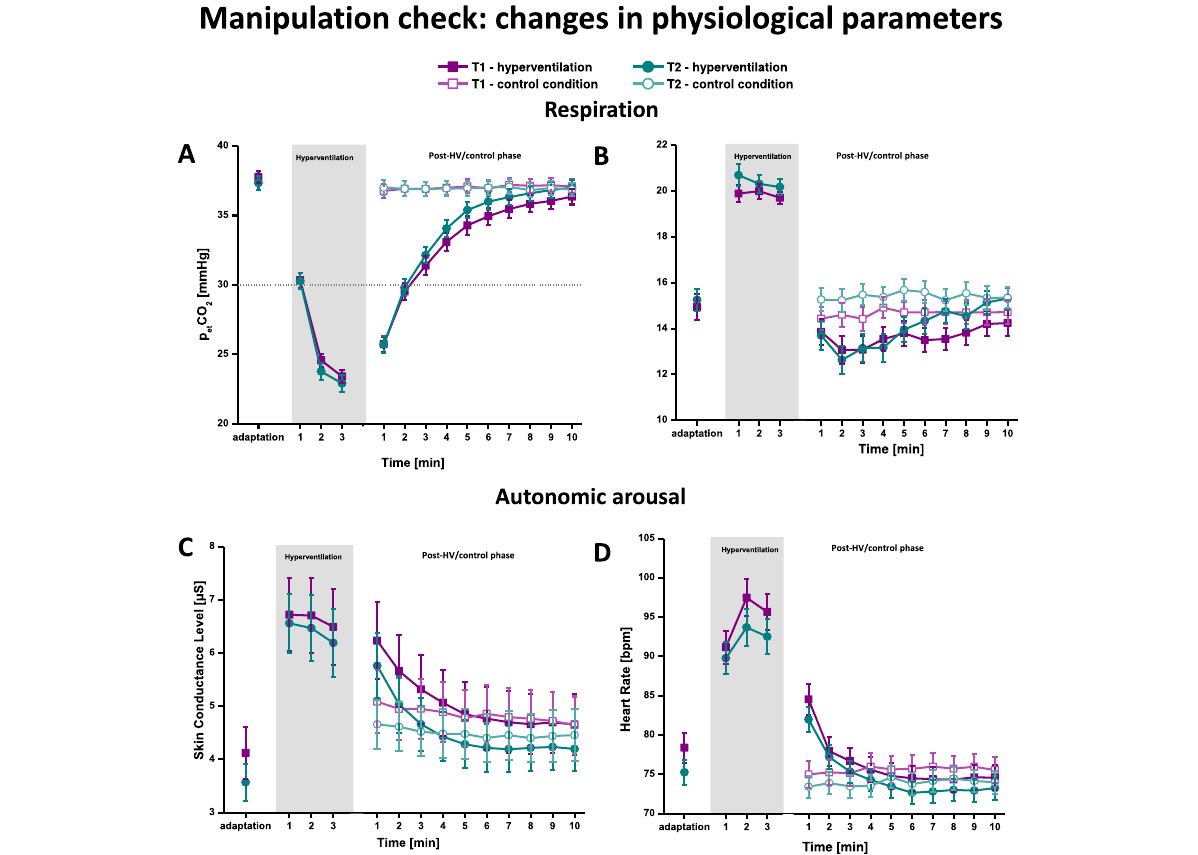
Fig. 1 Manipulation check: changes in physiological parameters during adaptation, hyperventilation and the post-hyperventilation phase/ control condition. Means of p et CO 2 ( A ), respiratory rate ( B ), skin conductance level ( C ), and heart rate ( D ) during adaptation, hyperventilation as well as the post-hyperventilation interoceptive threat phase and control condition at baseline (T1) and post-treatment